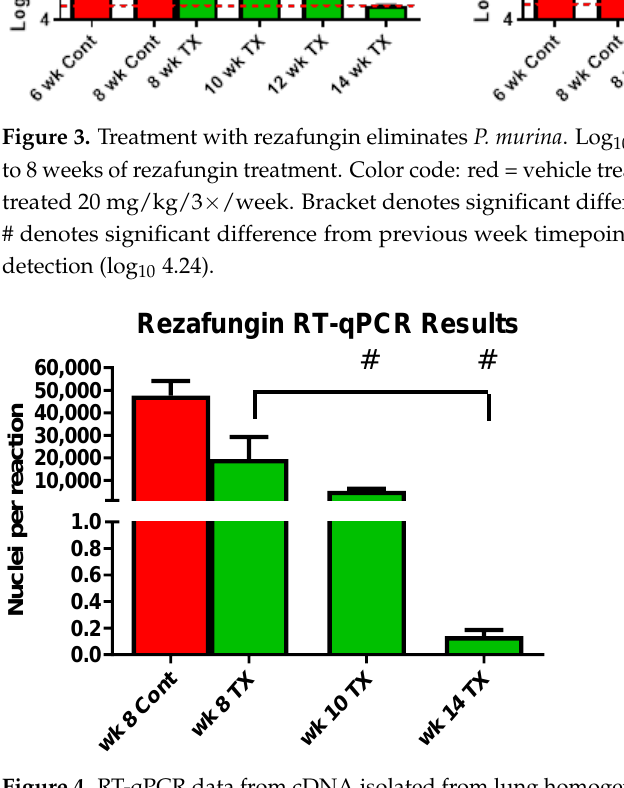
Figure 4. RT-qPCR data from cDNA isolated from lung homogenates and quantified using a TaqMan Assay. Color code: red = vehicle treated control bars; green = rezafungin-treated 20 mg/kg/3 × /week. TX = Treatment. Bracket denotes significant difference from 8-week control. # denotes significant difference from previous week timepoint. A 14 week signal is below detection.